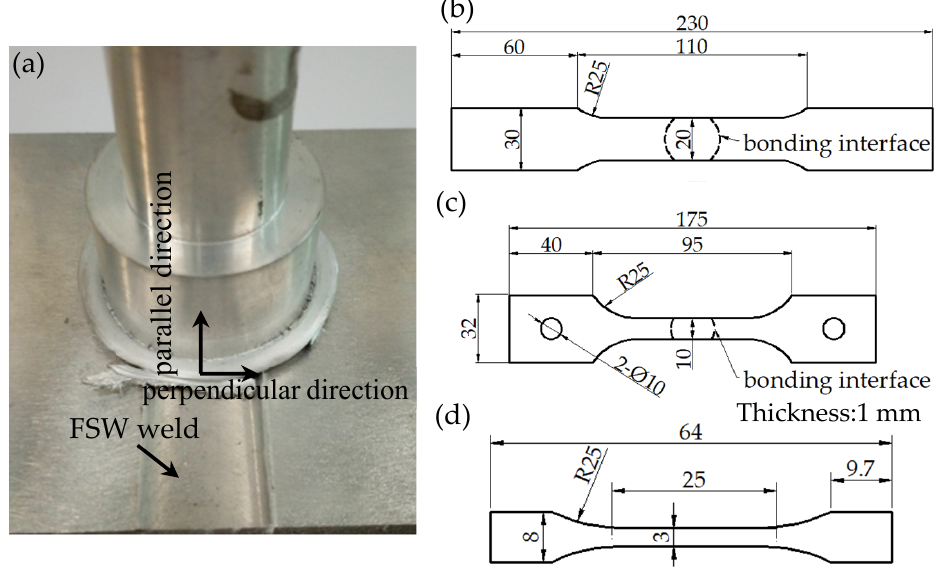
Figure 3. FPW joint for FSW weld and geometric dimensions of tensile specimens (mm): ( a ) FPW joint for FSW weld, ( b ) room temperature tensile specimen, ( c ) low temperature tensile specimen, and ( d ) micro-tensile specimen.